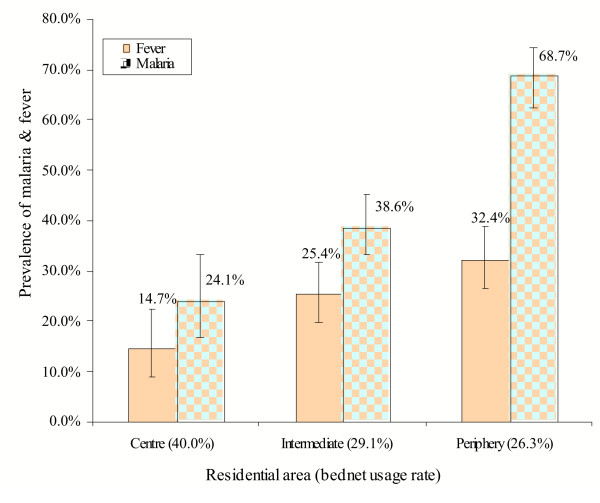
Malaria and fever prevalence in school children by area of residency. School parasitaemia survey. Vertical bars represent 95%CI.